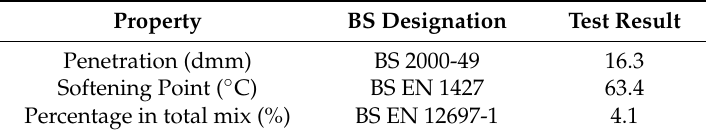
Table 4. Properties of recovered bitumen.